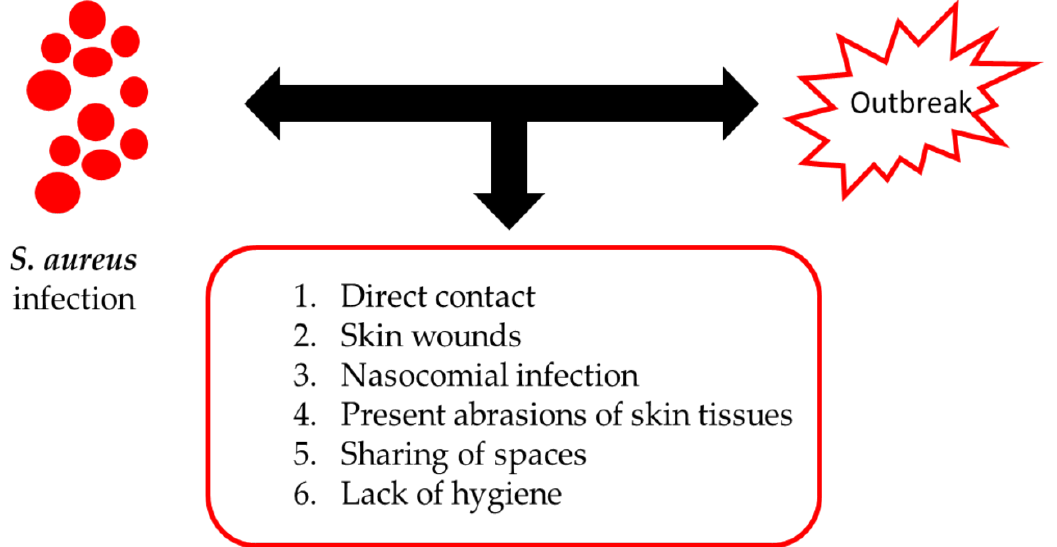
Figure 1. Risk factors associated with Staphylococcus aureus infections. .